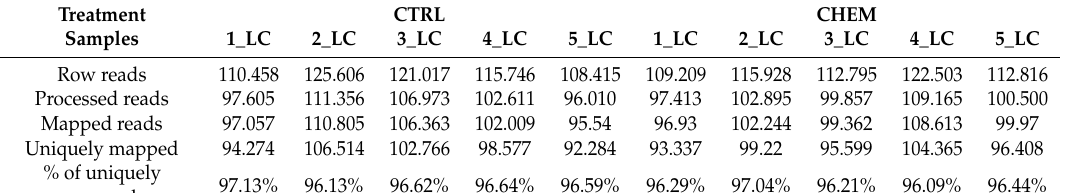
Table 2. Summary of the results of RNA sequencing, preprocessing and mapping of reads to the porcine reference genome. All numerical values are expressed in millions. CTRL are samples from control group, and CHEM are samples from chemerin-treated group.